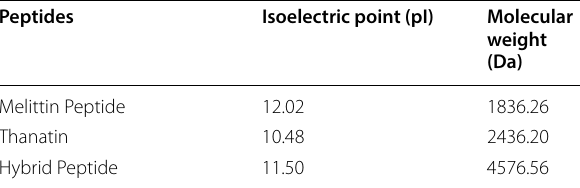
Table 1 Physicochemical properties of hybrid peptide Peptides Isoelectric point (pI) Molecular